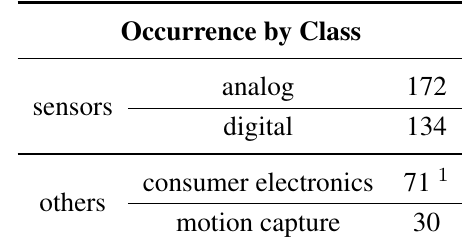
Table 3. Non-exclusive occurrence by